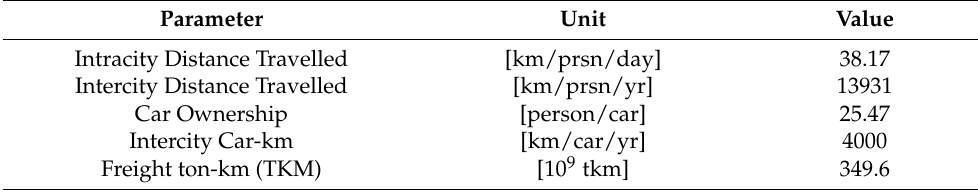
Table 9. Basic information related to passenger and freight activities.